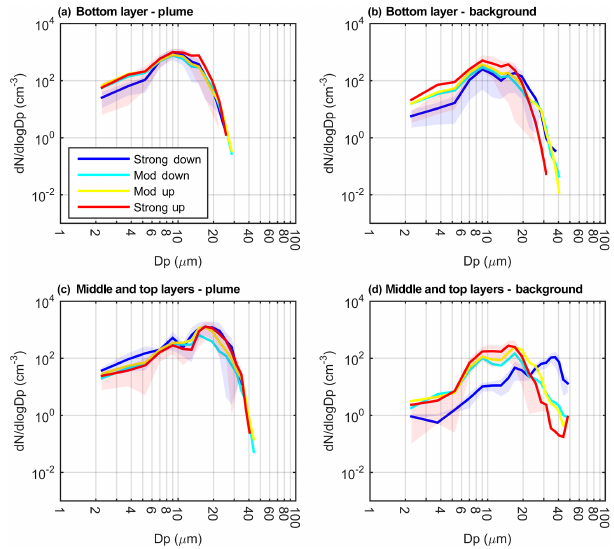
Figure 9. Averaged DSDs as function of altitude, presence of up- and downdraughts, and aerosol conditions. The first row shows re- sults for the bottom layer under (a) polluted and (b) background conditions. The middle and top layer results are shown together in the second row for (c) plume and (d) background conditions. “Strong down” means the presence of strong downdraughts, with velocities lower than − 2ms − 1 . “Mod down” is moderate down- draughts, with − 2ms − 1 <w ≤ 0. “Mod up” and “Strong up” are the equivalents for updraughts. Their velocity ranges are, respec- tively, 0 <w ≤ 2ms − 1 and w > 2ms − 1 . The shaded areas repre- sent the dispersion between the 25 and 75% for the strong down- draughts (in blue) and updraughts (in